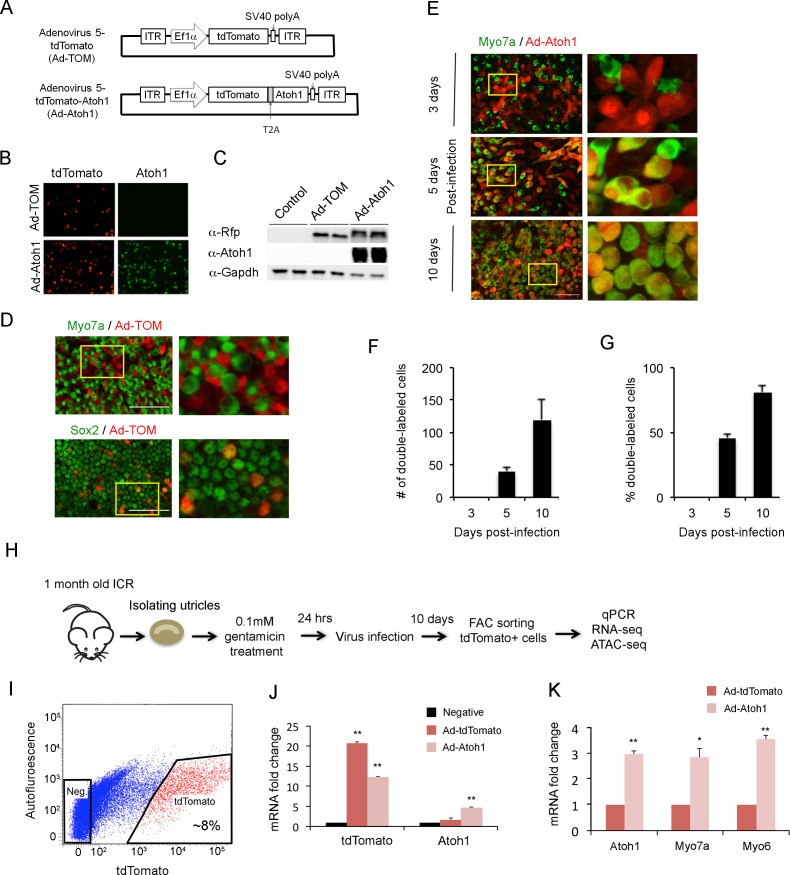
Overexpression of Atoh1 induces hair cell-like cells in the adult utricle.(A) Diagram of adenoviral vector constructs expressing tdTomato (Ad-TOM) and tdTomato and Atoh1 (Ad-Atoh1). ITR: inverted terminal repeat sequences, T2A: picornavirus T2A sequence. (B) Immunofluorescence staining for tdTomato and Atoh1 protein in 293 T cells infected with Ad-TOM or Ad-Atoh1 viruses. Scale bar, 50 µm. (C) Western blots for expression of tdTomato in 293 T cells infected with Ad-TOM or Ad-Atoh1 viruses. Duplicate lanes are shown for each condition. (D) Immunofluorescence staining for hair cell (Myo7a-cytoplasmic staining) and supporting cell (Sox2-nuclear staining) markers on utricle explants treated with Ad-tdTomato. After 48 hr, no tdTomato +cells express Myo7a, whereas all tdTomato +cells express Sox2. Optical sections are taken through the cell body at the level of the nucleus. Scale bar, 100 µm. (E) Infection of supporting cells with Ad-Atoh1 virus induces expression of the hair cell marker Myosin7a. Utricle cultures were examined 3, 5 and 10 days post-infection, with TdTomato marking the infected cells. The insets show enlarged images of the enclosed region by the yellow square. Scale bar, 50 µm. (F) Number of tdTomato +cells per 40x field (42,750 um2) expressing Myo7a increases over the 10 day culture period. Error bars show mean ± SEM (n ≥ 6 utricles). (G) Percentage of tdTomato +cells expressing Myo7a increase over the 10 day culture period. Error bars show mean ± SEM (n ≥ 6 utricles). (H) Schematic diagram of experimental procedure for obtaining tdTomato- and Atoh1-expressing cells for RNA-seq and ATAC-seq. (I) Sample FACS profiles showing the distribution of tdTomato positive cells (red) in the virally-infected utricle cultures. (J) Q-PCR analysis of infected cells shows robust expression of tdTomato with both Ad-TOM and Ad-Atoh1 viruses, but expression of Atoh1 only in Ad-Atoh1-infected cultures. Error bars show mean ± SEM (n = 3) (*p<0.05; **p<0.01 compared with negative control) (K) Hair cell transcripts (Myo7a and Myo6) are up-regulated in Ad-Atoh1-infected cultures, but not control (Ad-TOM) cultures (n = 3) (*p<0.05; **p<0.01).